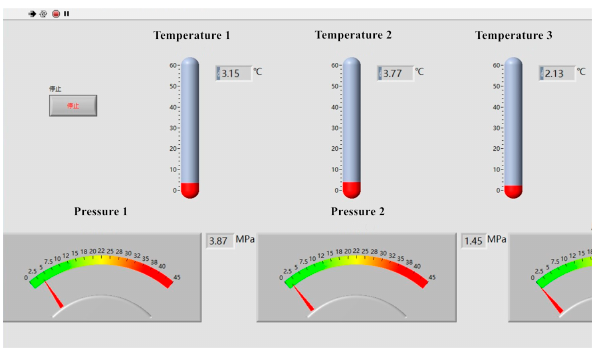
Figure 17. Temperature measurement of the system (signal acquisition software).